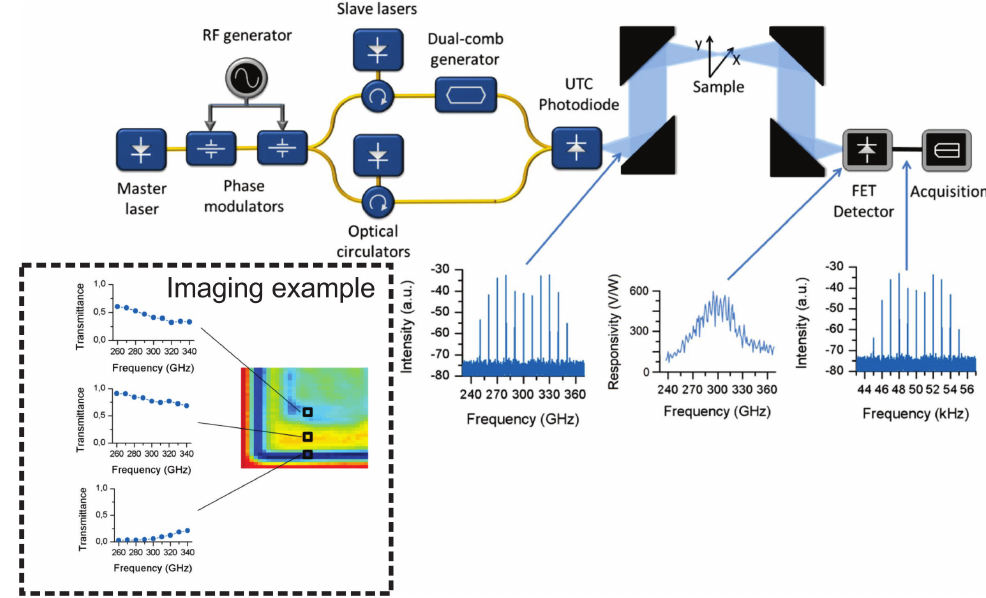
Figure 7. Block diagram of the THz dual-comb imaging system. The first optical frequency comb is generated from the output of the master laser by two phase modulators, and then two teeth (with a frequency spacing equal to the central THz signal to be generated) are filtered by optical injection locking and a dual-comb signal is created from one of them; both signals are recombined on an uni-traveling-carrier (UTC) photodiode. The emitted THz signal is focused on the sample plane and detected later by a FET detector. The insets show (from left to right) the spectrum of the THz dual-comb, the responsivity of the FET detector and the spectrum of the multi-heterodyne signal after detection. The imaging example presents the transmittance spectra through the complex plastic sample at several locations, enabling a straightforward separation between plastic layers (differences in the overall absorbance and the frequency dependent slope) and the edge diffraction. Reproduced from Ref.